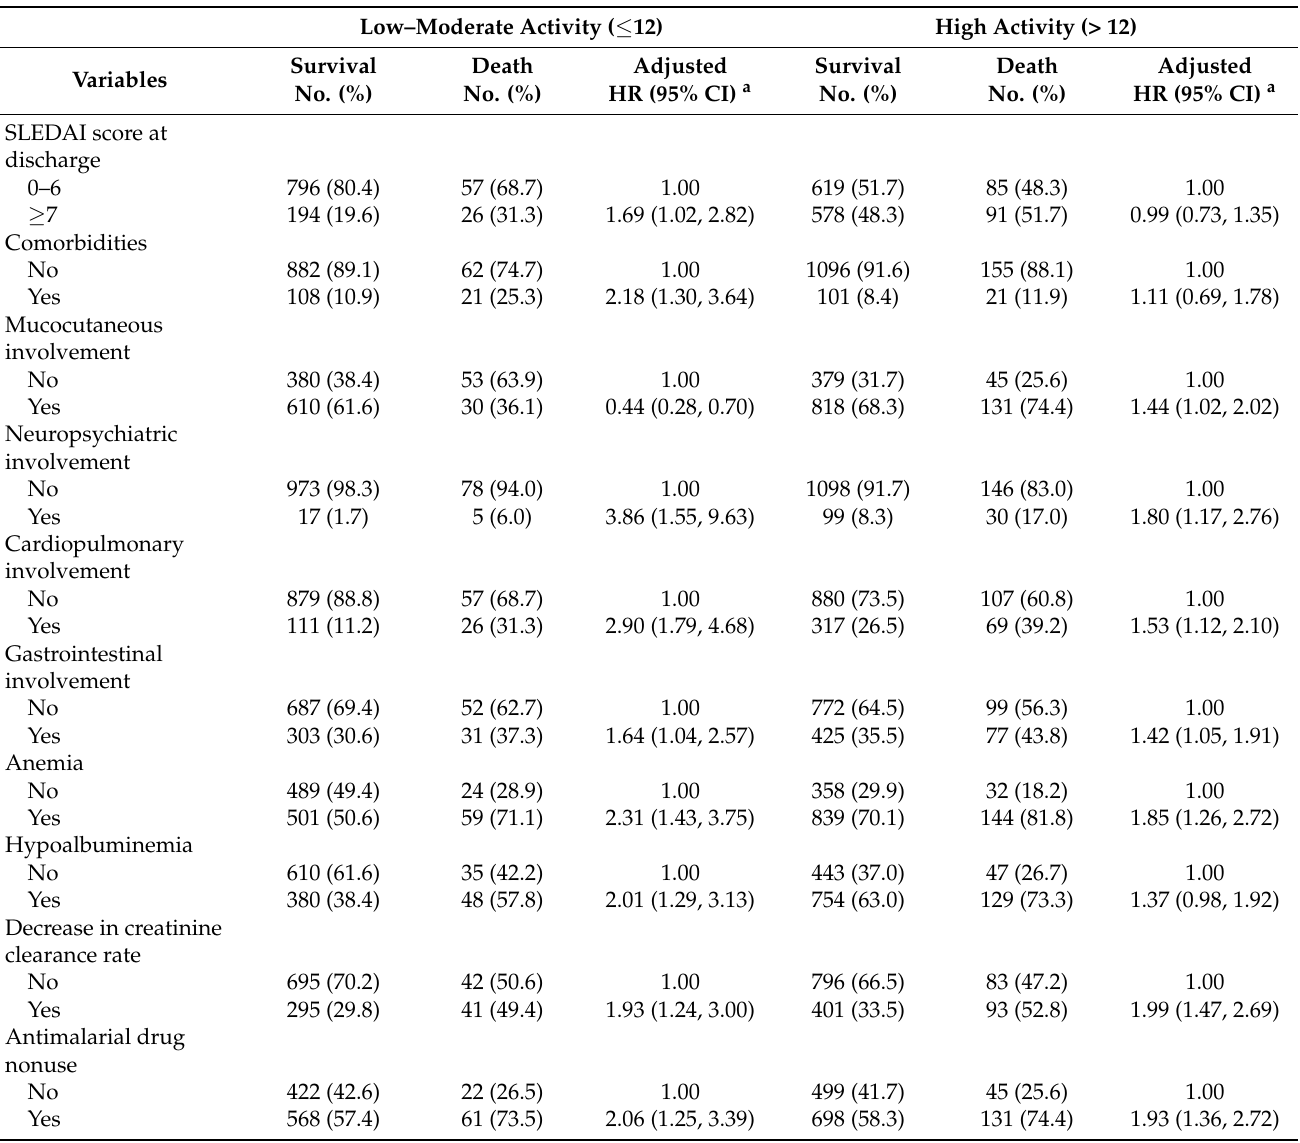
Table 2. Major risk factors associated with death in patients with SLE by initial SLEDAI score on admission.